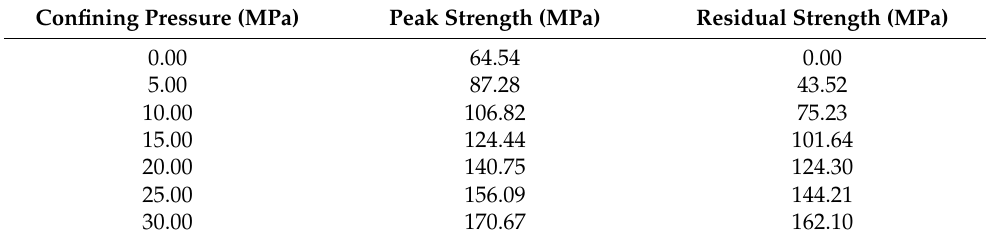
Table 1. The peak strength and residual strength of the simulated rock material. Confining Pressure (MPa)